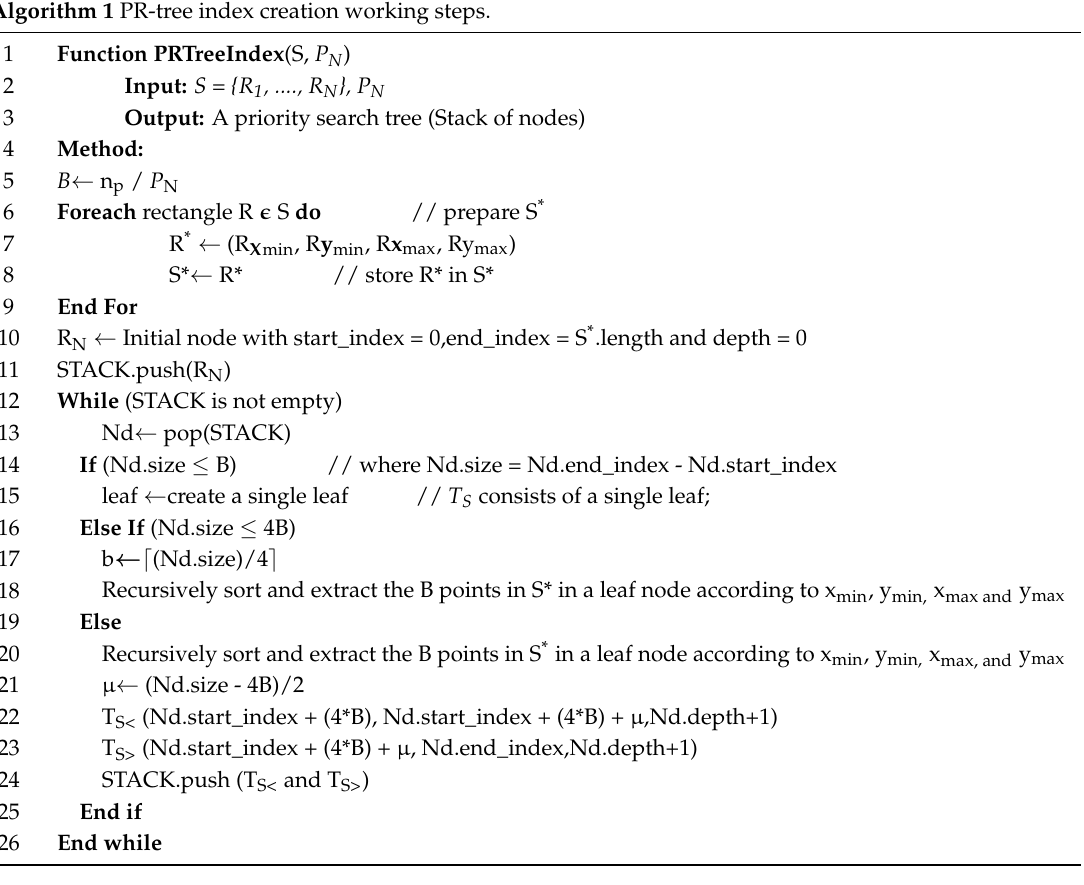
Algorithm 1 PR-tree index creation working